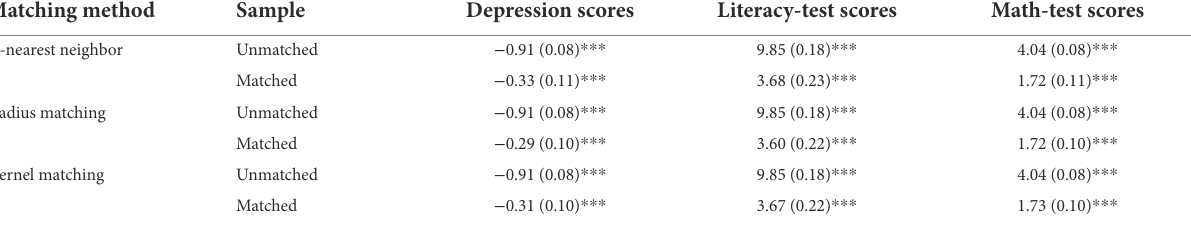
TABLE 3 PSM analysis of Internet use and mental health. Matching method